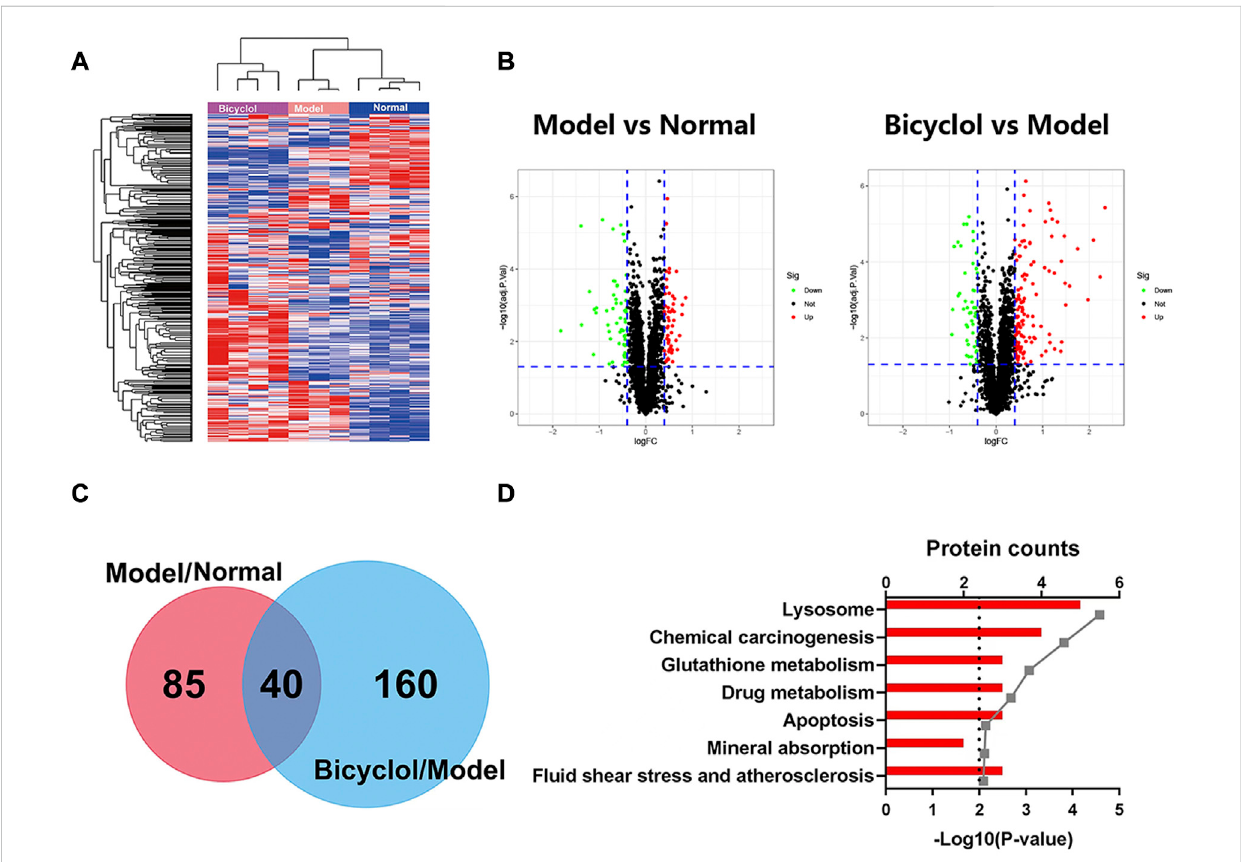
FIGURE 3 Heatmap, Volcanoplot, Venn map, KEGG pathways analyses for the changed proteins. Log 2-transformed ratio of < − 0.4 or > 0.4 and p < 0.05 were consideredstatisticallysigni fi cant. (A) Hierarchical clustering heatmapfor allthechangedproteins. (B) Volcanoplots ofthetwocomparisons.Green dots representdownregulatedproteins,reddotsrepresentupregulatedproteins,blackdotsrepresentnotdifferentiallychangedproteins. (C) Vennmapofthe two comparisons. (D) KEGG pathways analyses of 40 deregulated proteins in both Model vs Normal and Bicyclol vs Model